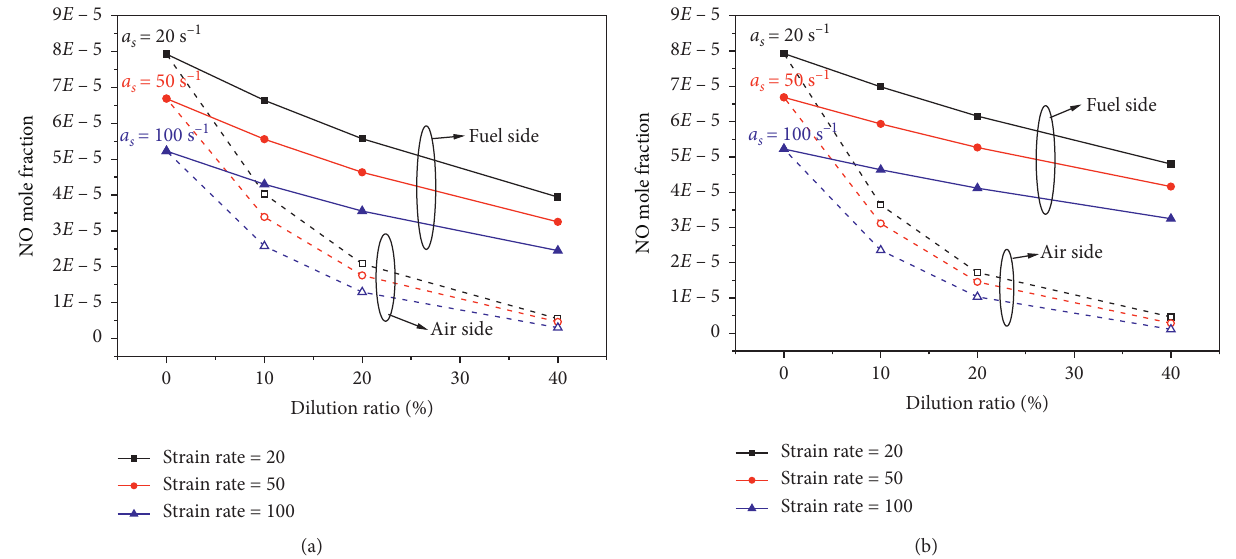
Figure 7: The peak NO mole fraction of CH 4 /air counterflow diffusion flames with different strain rates: a s 100s − 1 (blue). L � 2cm, 400K. (a) H 2 O dilution. (b) CO 2 dilution.